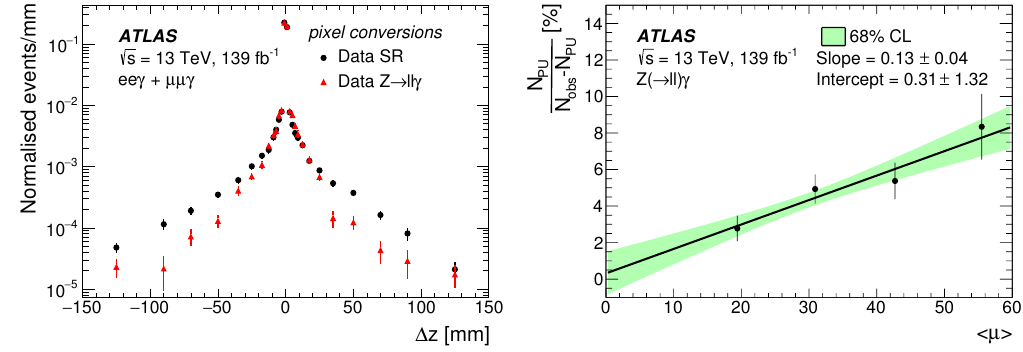
Figure 3 . Left: distributions of (cid:1) z for pixel conversion photons in the SR and in the Z ! ‘‘(cid:13) control region. Right: the ratio of the number of events where the photon candidate arises from a pile-up interaction to that where it arises from the same interaction as the Z boson, is shown versus h (cid:22) i . A straight-line (cid:12)t to the data is also shown, and the intercept and the slope of the (cid:12)t are given in the (cid:12)gure. The error bars on the ratios are uncorrelated between di(cid:11)erent values of h (cid:22) i , and are due to the limited number of data and MC events. The shaded band shows the e(cid:11)ect of the uncertainties in the (cid:12)tted